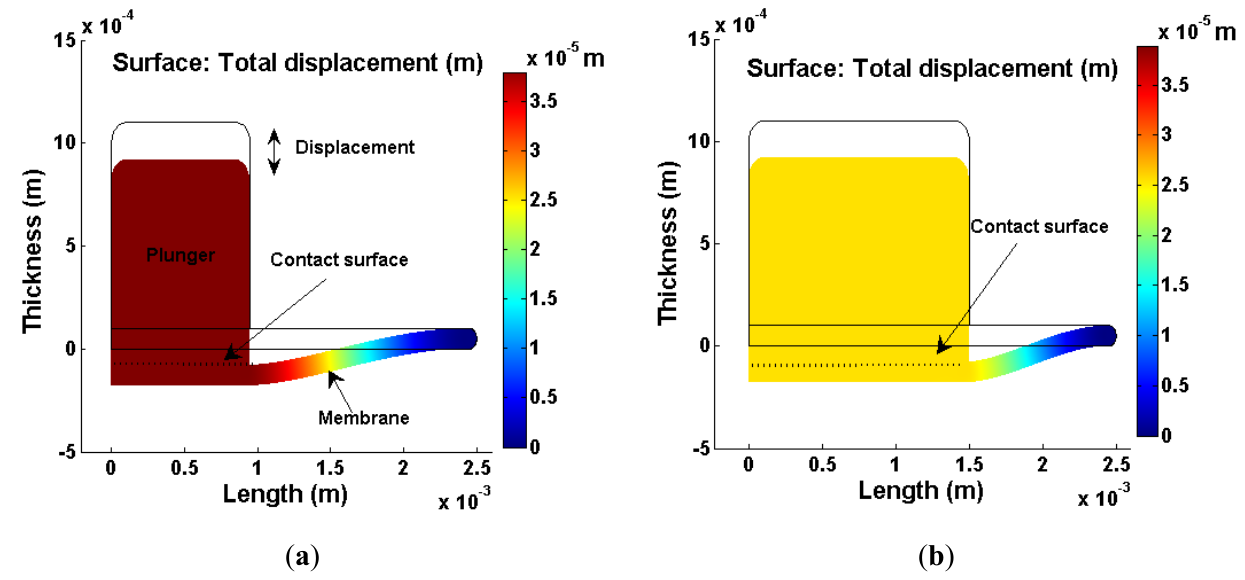
Figure 3. Membrane deflection caused by body load, 100 N/m 3 . ( a ) 3.89 × 10 − 5 m